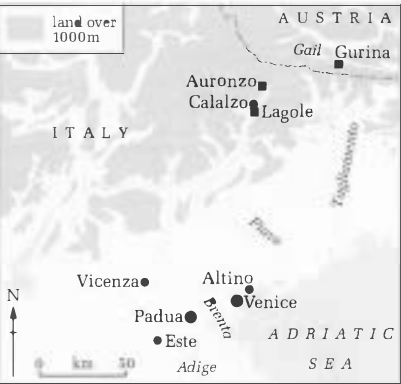
Figure 1 The region of the